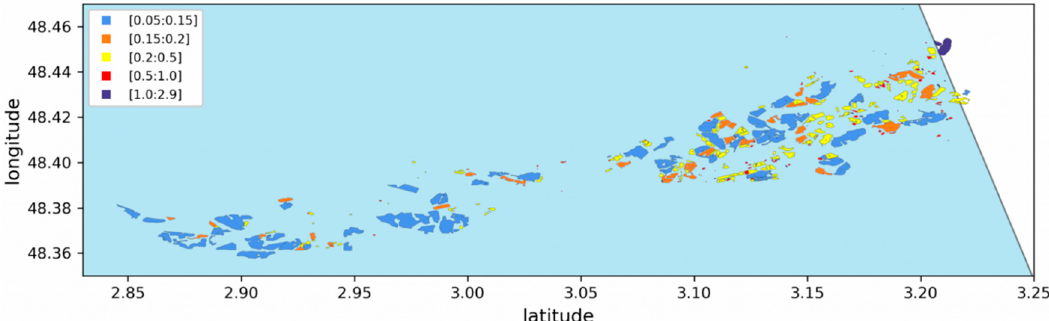
Figure 4. Standard deviation of the SWOT-like errors simulated on the gravel pits of the western part of the La Bassée region and for the Orbit 292 for the five-year period studied.